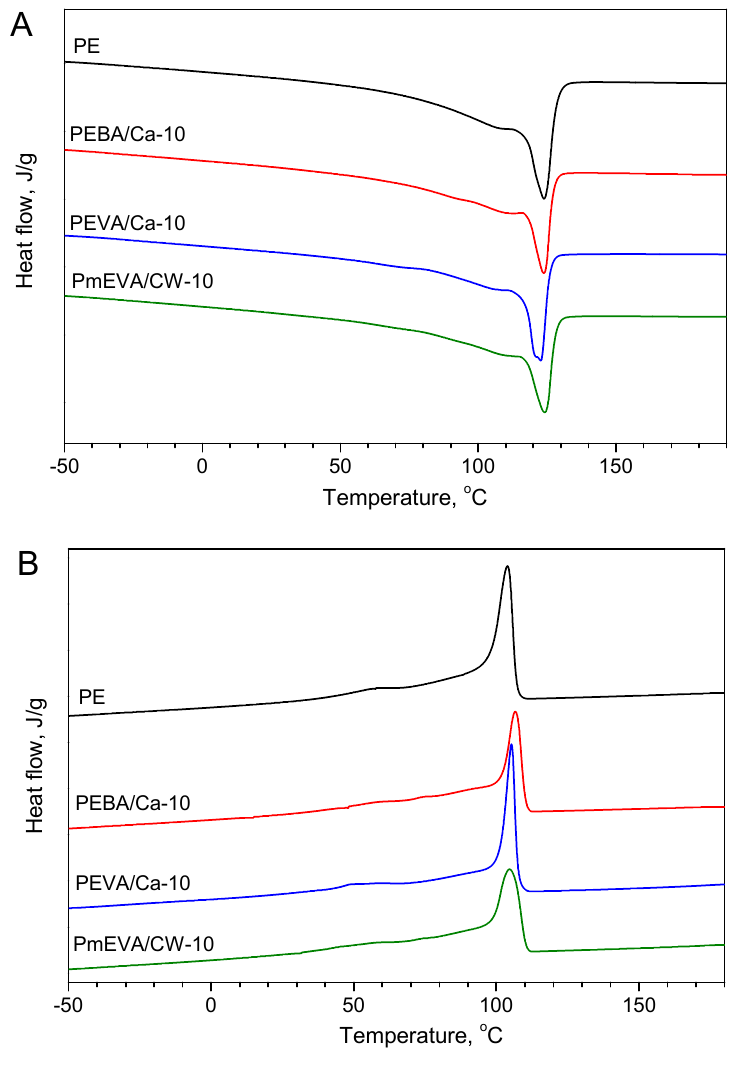
Figure 6. DSC curves at heating ( A ) and cooling modes ( B ) for PE composites with the highest MMT content.